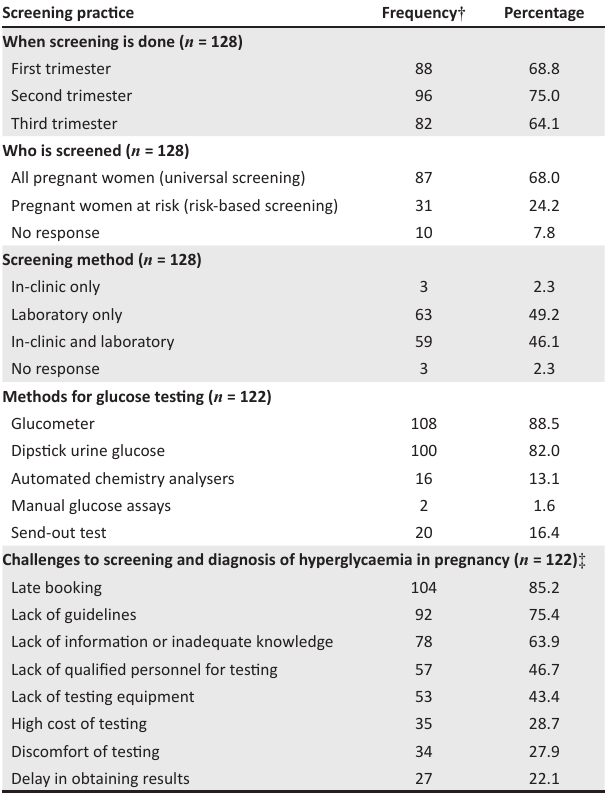
TABLE 2: Summary of screening practices and challenges according to antenatal healthcare providers in healthcare facilities in Jos North, Plateau state, Nigeria, August to September 2019.